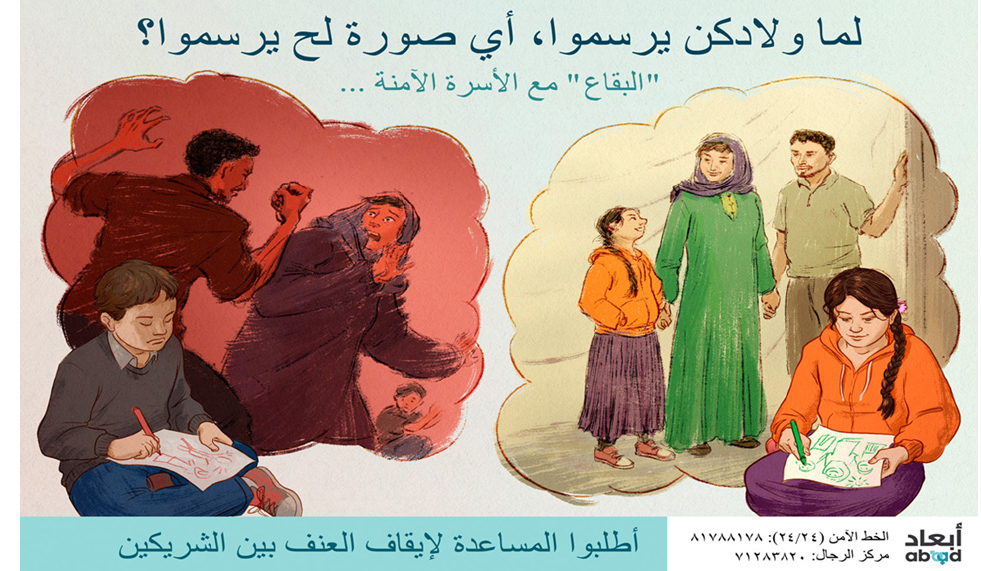
Figure 2. Lebanon campaign poster, final version. English translation, Main Slogan: When Your Chil- dren Draw Their Family, Which Picture Will They Draw? Sub-slogan: Al Bekaa Supports Safe Families.